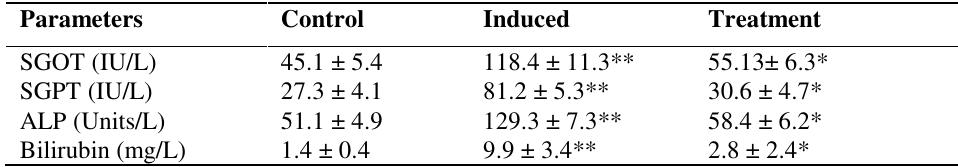
Table 1. Effect of L. edodes extract on liver marker enzymes and serum bilirubin content.